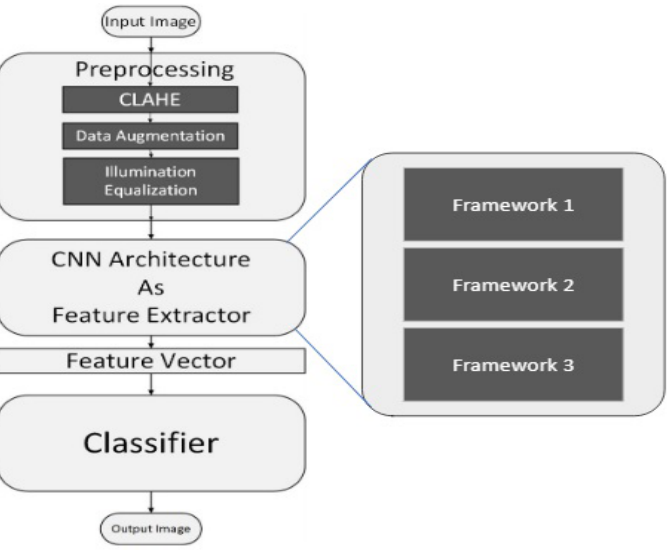
Figure 1. Block diagram of the proposed algorithm.